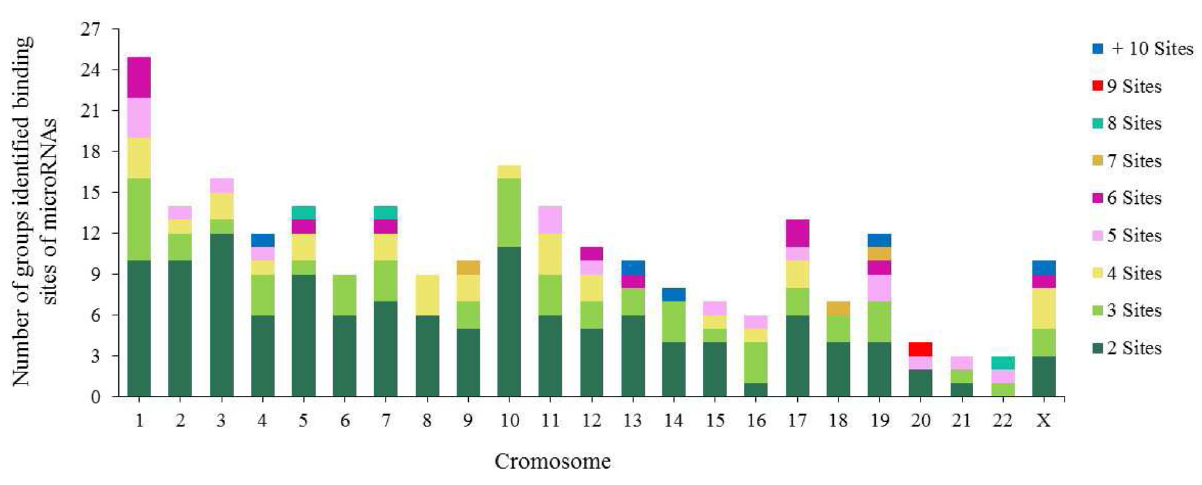
Figure 4. Chromosomic distribution of groups identified binding sites of miRNAs